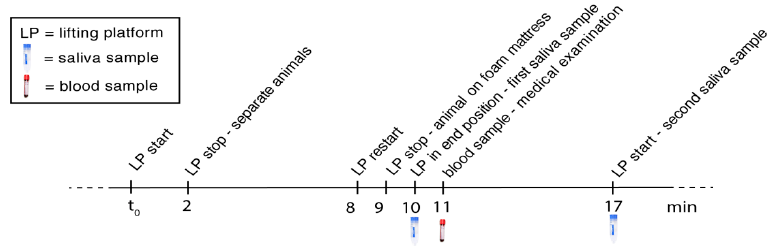
Figure 3. Exemplary sampling scheme for the simultaneous blood and saliva sampling.